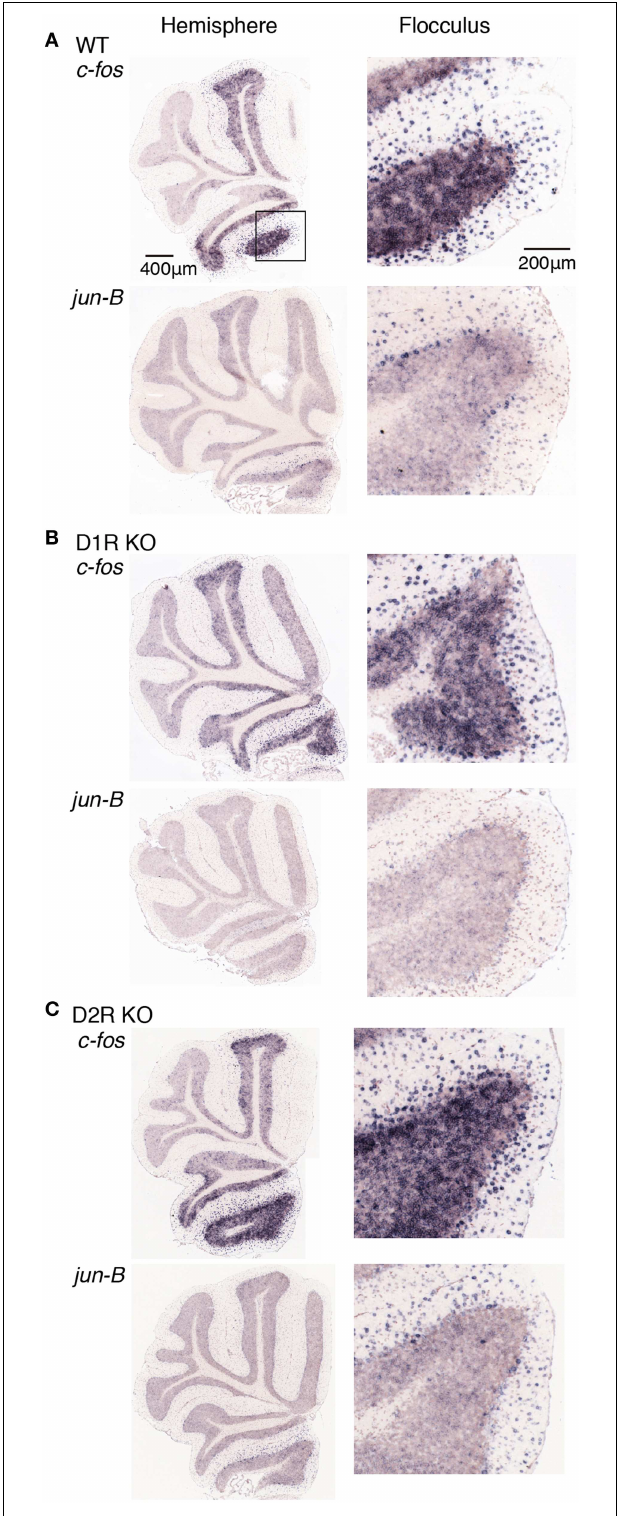
FIGURE 8 | Expression levels of c-fos and jun-B mRNAs in the cerebellum of trained mice after riding on stationary rota-rod. (A)